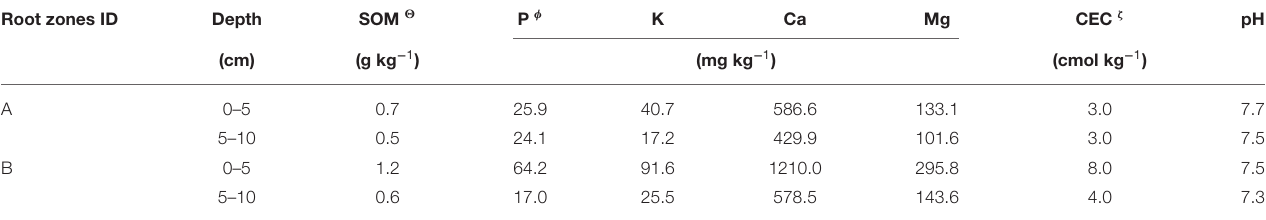
TABLE 1 | Soil chemical properties of two putting green root zones. Root zones